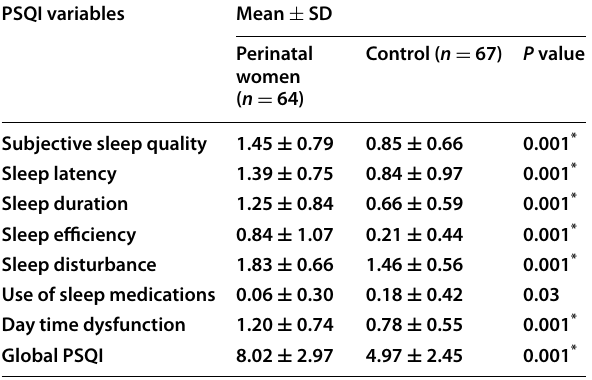
Use of sleep medications 0.06